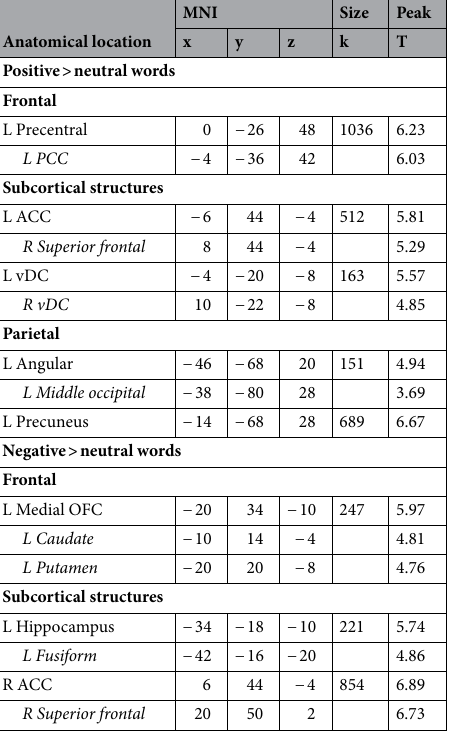
Table 3. Adults’ activation for the contrasts positive words compared to neutral words and negative words compared to neutral words (FWE corrected, p < 0.05, cluster level). x, y, z peak coordinates according to MNI stereotactic space, k cluster size in voxels, T - values for peaks, R right, L left, PCC posterior cingulate cortex, ACC anterior cingulate cortex, vDC ventral diencephalon, OFC orbitofrontal